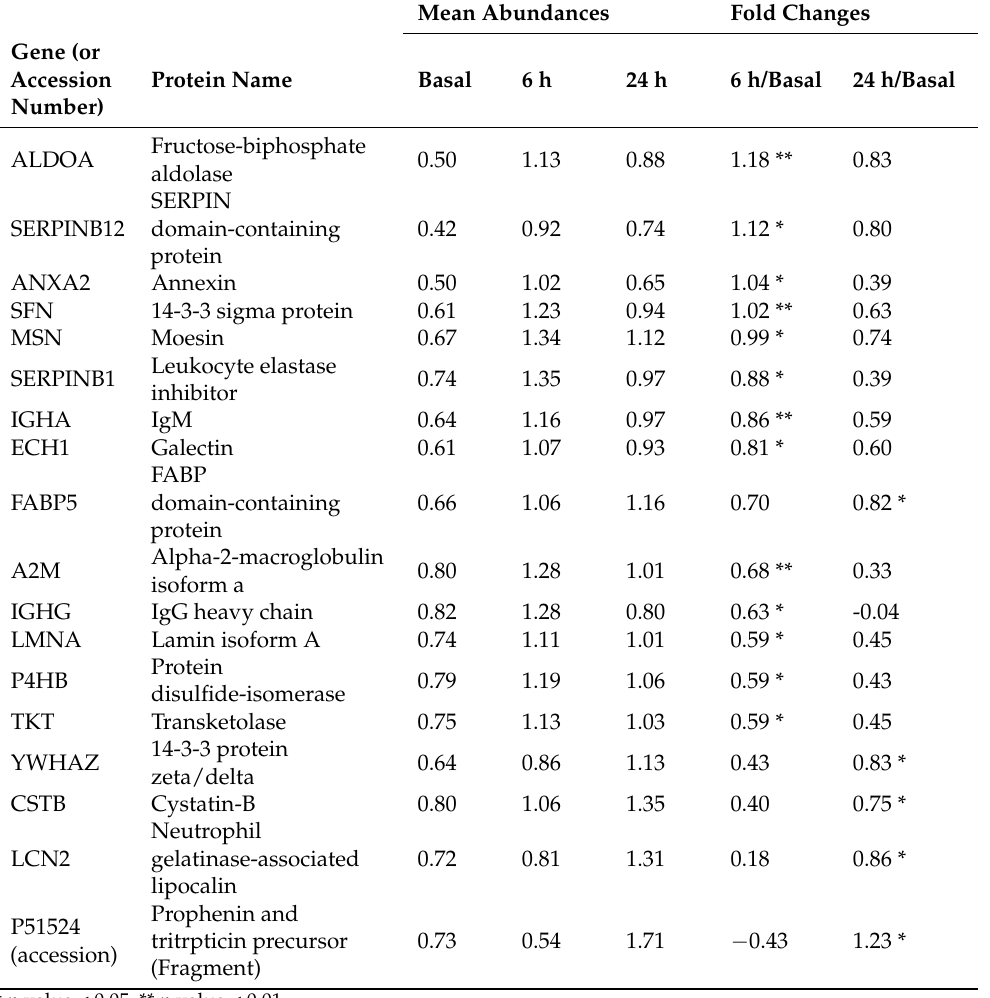
Table 1. Differentially expressed salivary proteins in pigs with experimentally-induced